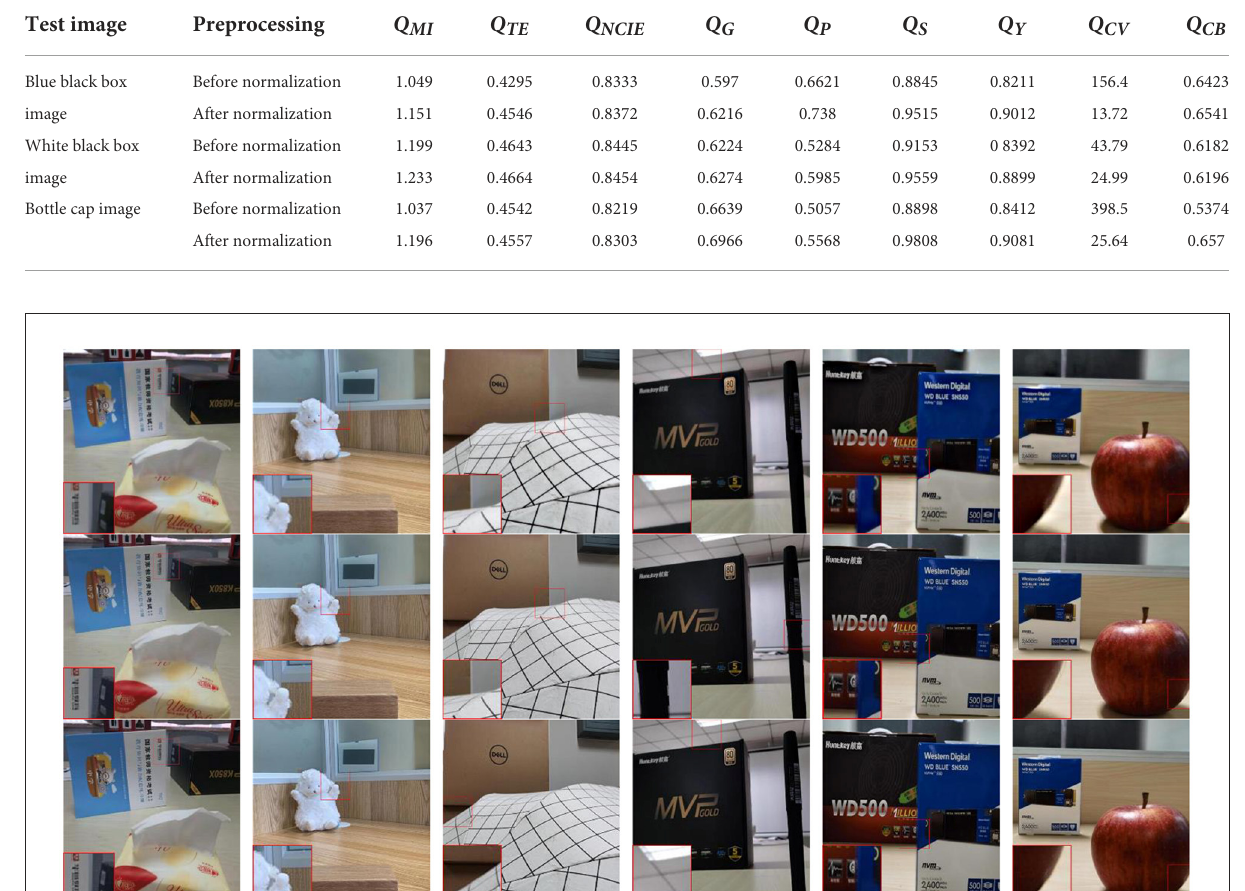
of fused images is bolded. As can be seen from the Table 4,